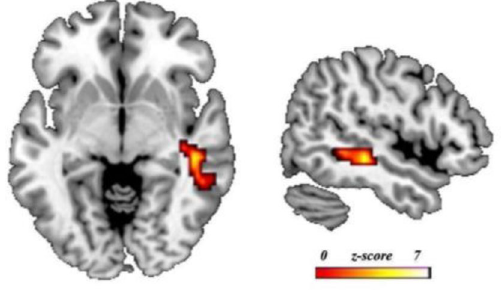
Figure 2. Differences in brain activation in the fMRI RE-task group analysis. Note Results of two-sample t-tests between the RE and non-RE groups. Figure represents the RE group > non-RE group contrast. Results were p < .05 FWE cluster-corrected using a threshold of p < .005 at the uncorrected voxel level and a cluster size of k = 258 voxels. Coordinates are in the MNI space. The left/right of the image corresponds to the left/right brain